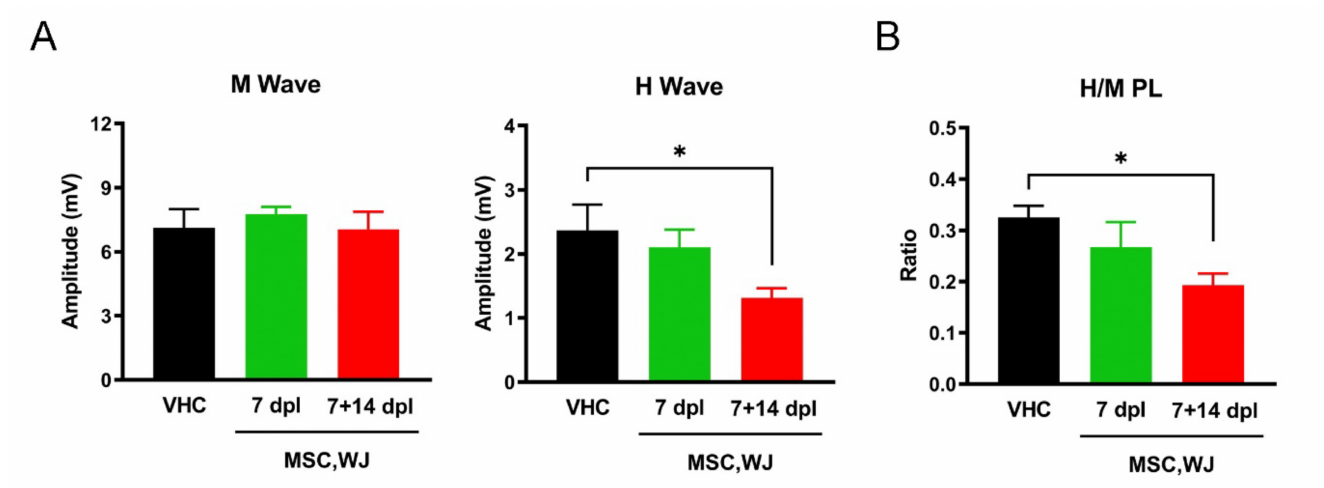
Figure 4. Motor nerve conduction studies at 70 dpi. ( A ) Amplitude of M and H waves recorded in the plantar muscles. The H wave was significantly reduced in MSC,WJ 7 + 14 days post-lesion (dpl) vs. vehicle (VHC). ( B ) Spinal reflex H/M ratio of plantar muscle showed a significant decrease in MSC,WJ 7 + 14 dpl group vs. VHC. (* p < 0.05). n = 5 per